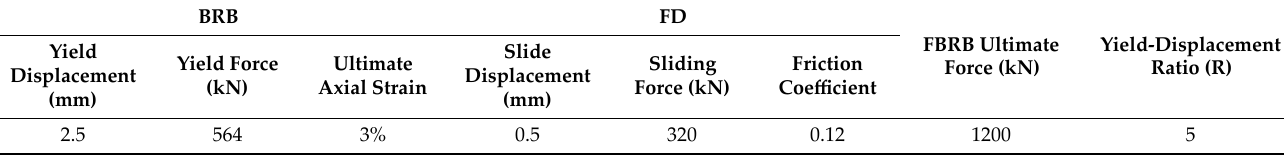
Table 3. Performance parameters of the FBRB specimen.